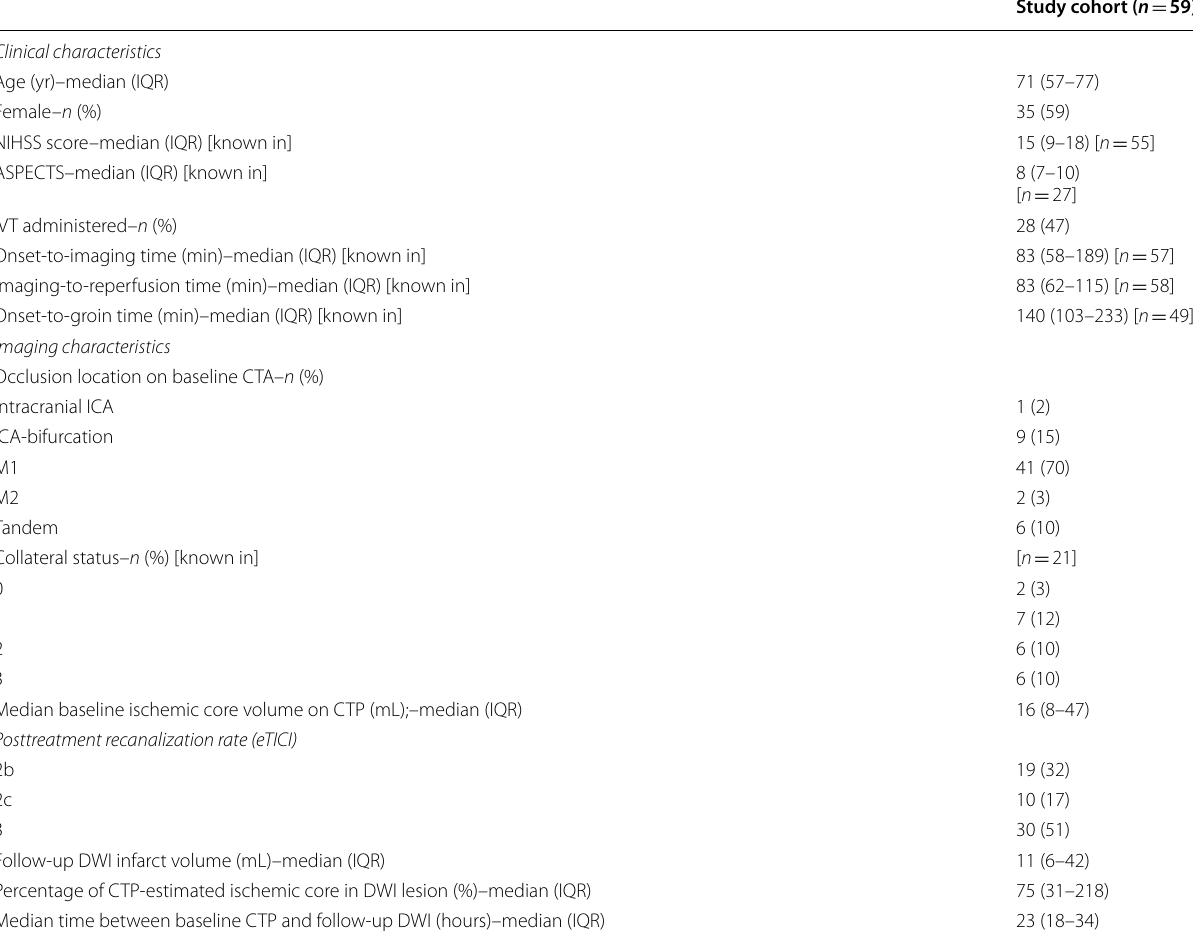
Table 1 Baseline clinical characteristics